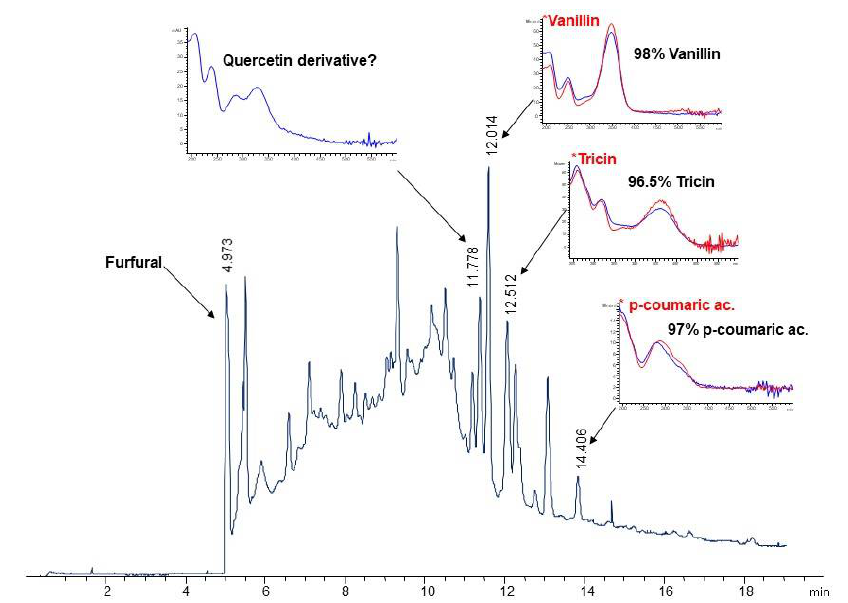
Figure 5. Electropherogram showing the phenolic profile for non-catalysed ethanol organosolv hydrolysates from wheat straw (190 ◦ C, 120 min). Matching was obtained via comparison with authentic standards (*) run under the same conditions as the sample.